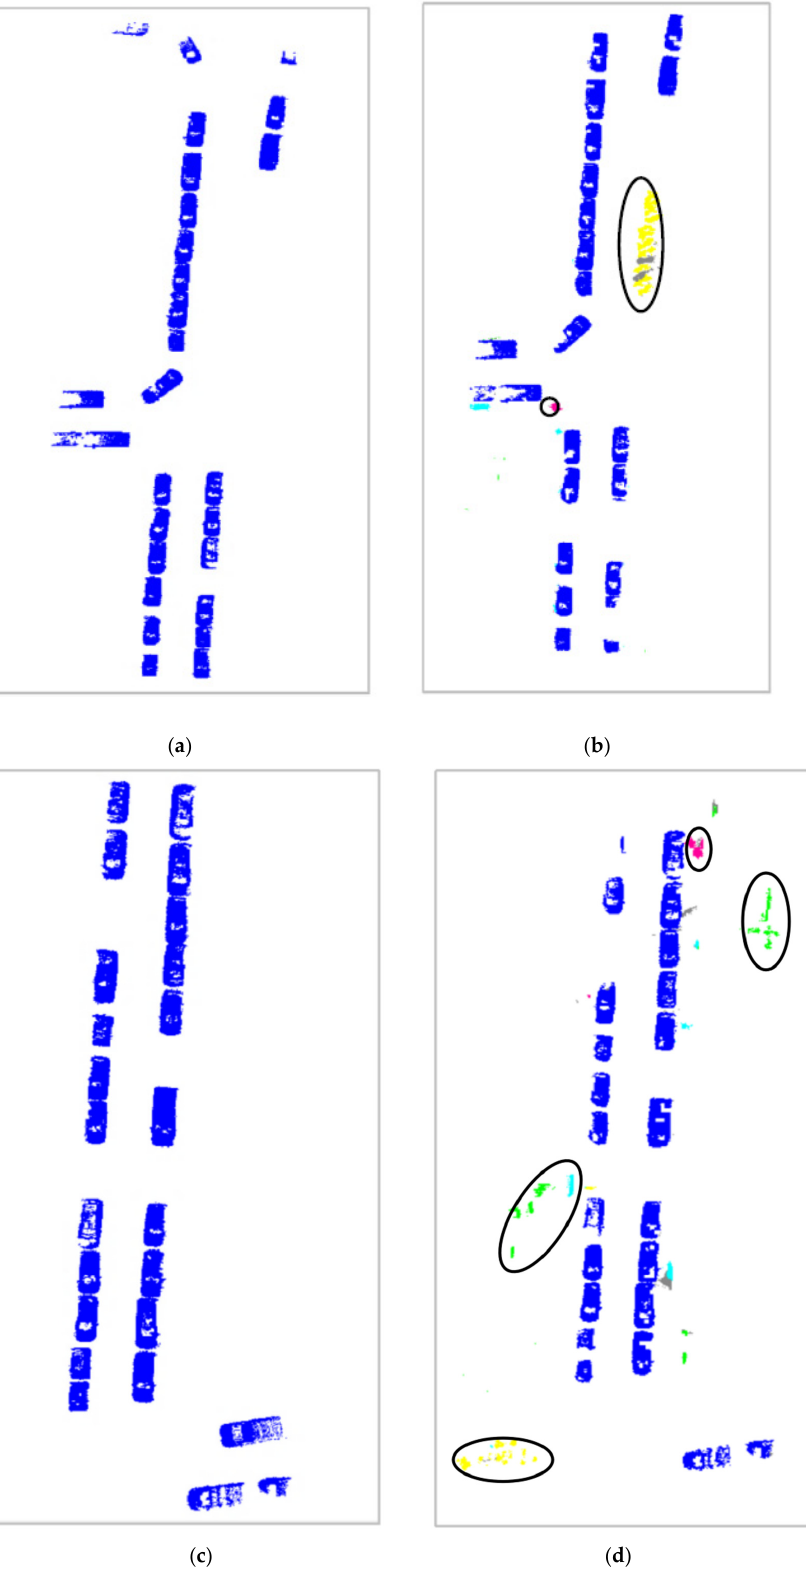
Figure 12. The view comparison of vehicle recognition results with ground truth in regions A and B. Note: actual location of vehicles respectively in the area A and B ( a , c ); vehicle recognition results respectively in the area A and B ( b , d ). Vehicles in dark blue ( a – d ), objects in other colors are misidentified as vehicles ( b , d ).